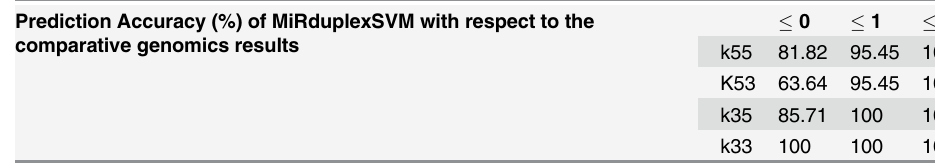
MiRduplexSVM versus comparative genomics on missing duplexes prediction. The table shows the prediction accuracy per corner of MiRduplexSVM when the results of a comparative genomics approach are set as the ground truth. When considering an error tolerance of up to 2nts, MiRduplexSVM gives exactly the same predictions as a strict comparative genomics algorithm.